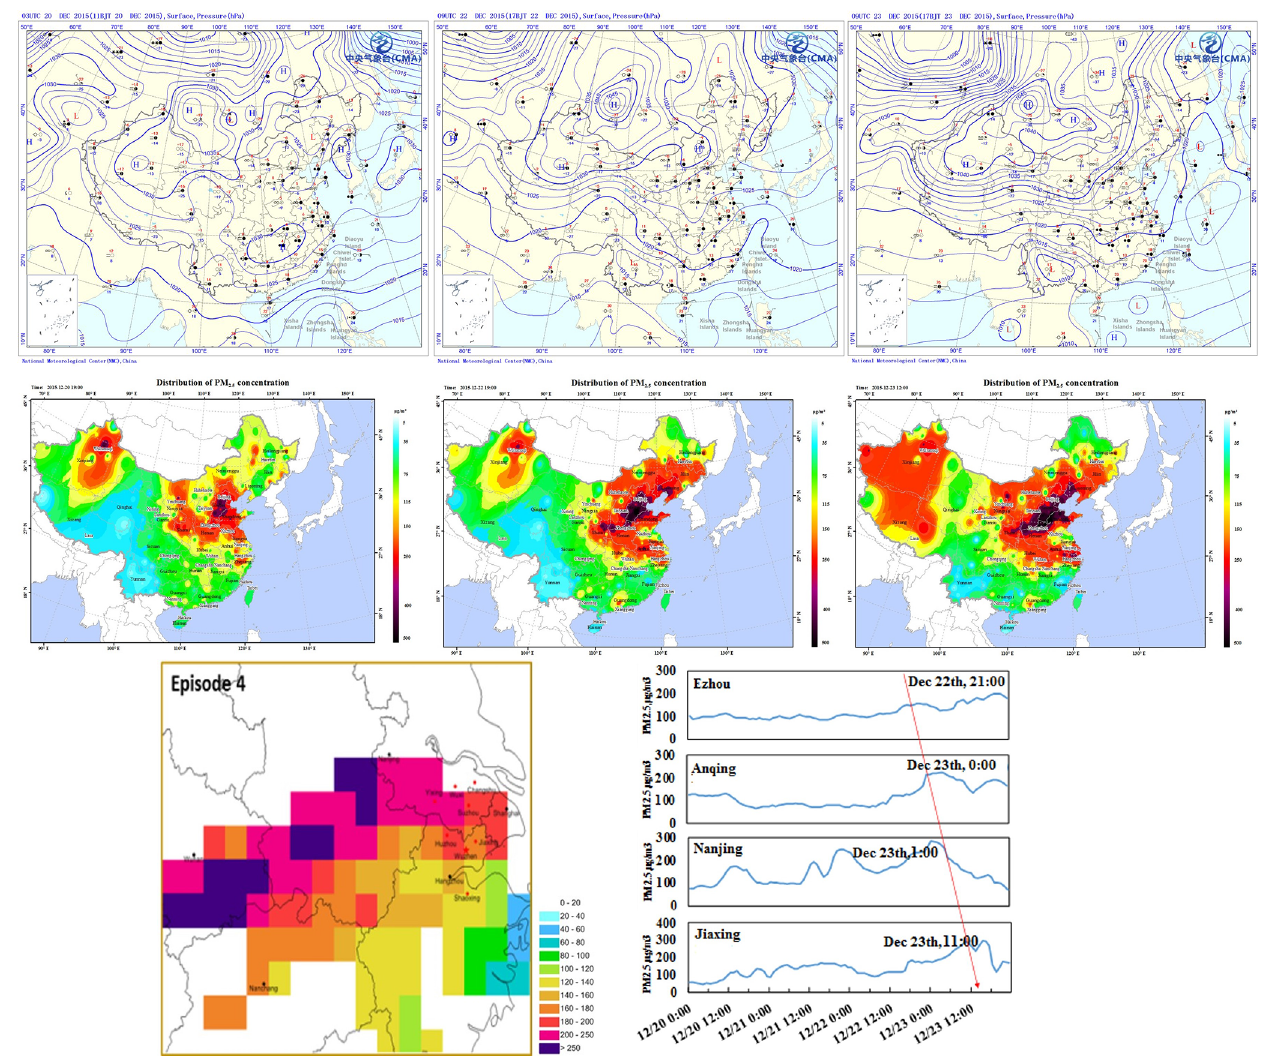
Figure 8. Analysis of (a) the large-scale weather patterns, (b) distribution of PM 2 . 5 concentrations, (c) potential regional sources, and (d) observed PM 2 . 5 time series for select sites during 20 to 23